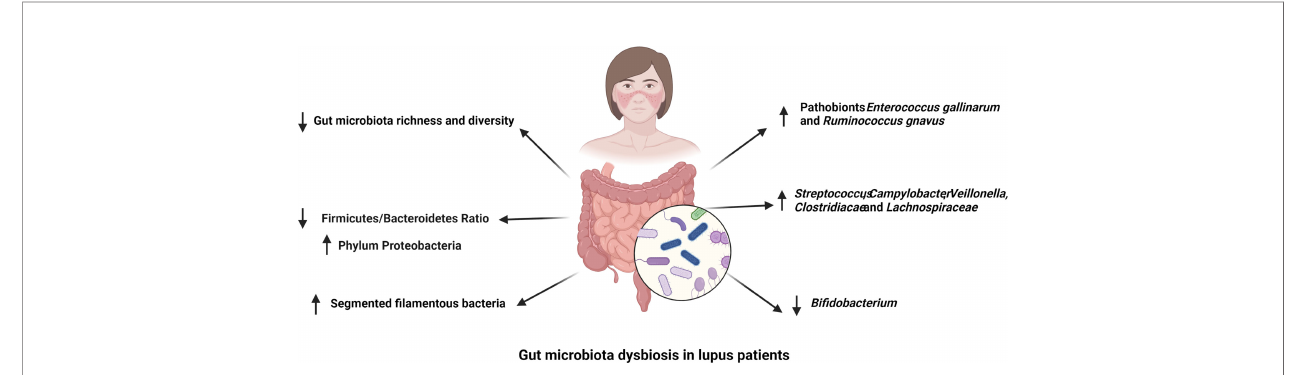
FIGURE 1 | Gut microbiota dysbiosis in lupus patients. The richness and diversity of gut microbiota as well as the Firmicutes to Bacteroidetes ratio are decreased in different cohorts of lupus patients. Segmented fi lamentous bacteria have been reported to have a higher abundance in the gut microbiota of lupus patients. The abundance of Streptococcus , Campylobacter , Veillonella , Clostridiacae and Lachnospiraceae are positively correlated to SLE disease activity, while that of Bi fi dobacterium is negatively associated with lupus activity. Finally, pathobionts Ruminococcus gnavus and Enterococcus gallinarum are enriched in the gut of lupus